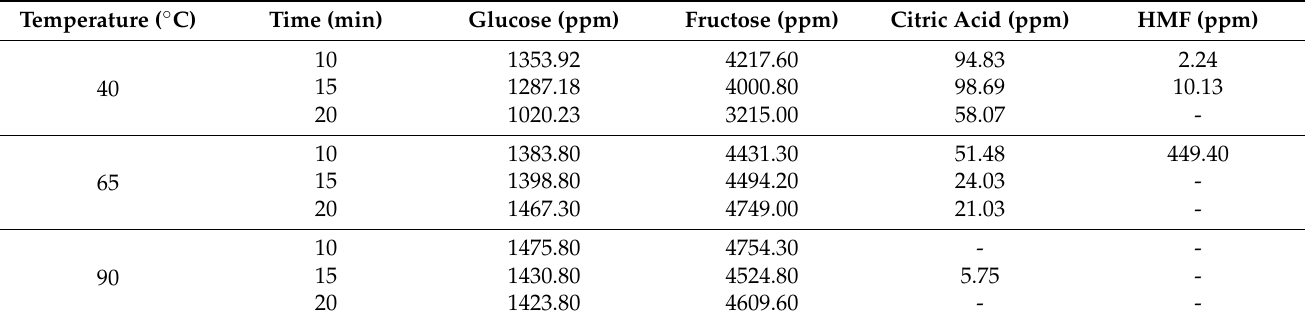
Table 7. Sugar and by-product analysis of the obtained samples at different temperatures and extraction times (at 50% of